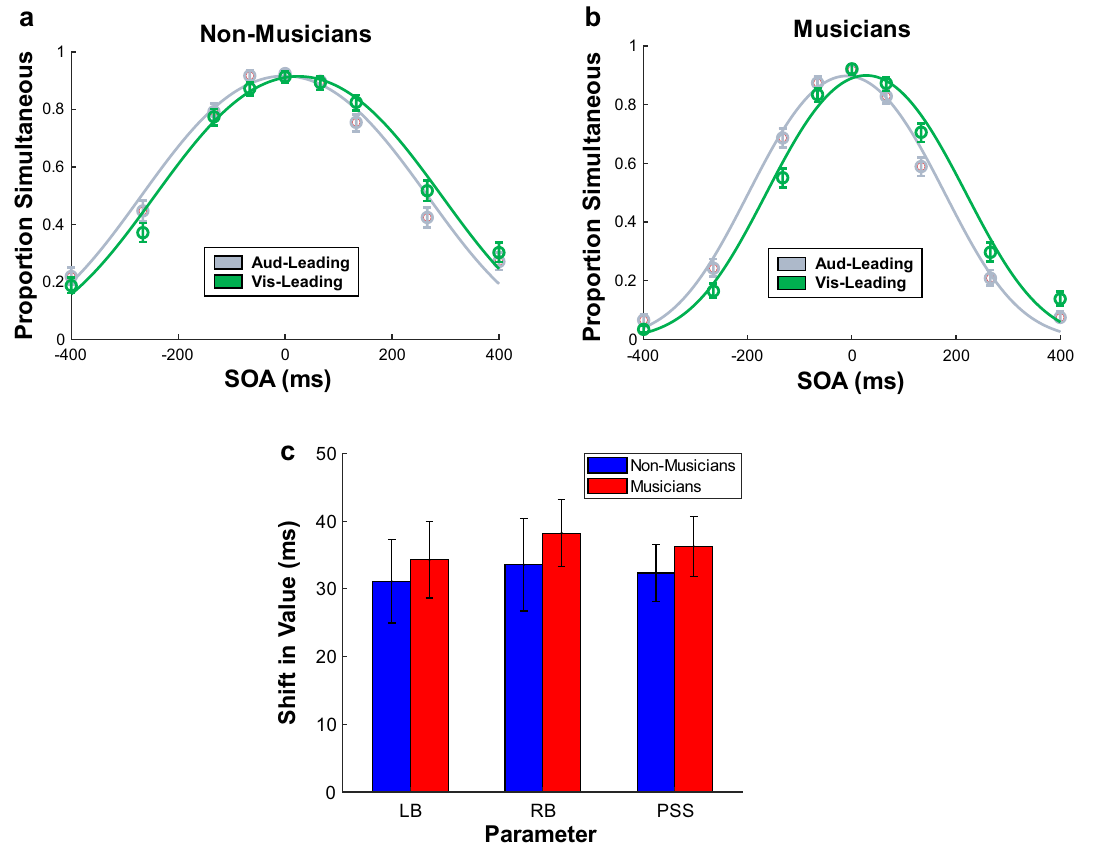
Figure 4. Group observer model fits for ( a ) non-musicians and ( b ) musicians show the rapid recalibration experienced by both groups (across all experimental phases), as denoted by a shift in the decision boundaries towards the modality order (auditory-leading or visual-leading) experienced on the previous trial. As shown by ( c ), there were no significant group differences in rapid recalibration of the left boundary (LB), the right boundary (RB), or the average of the boundaries (PSS). Error bars show one standard error of the